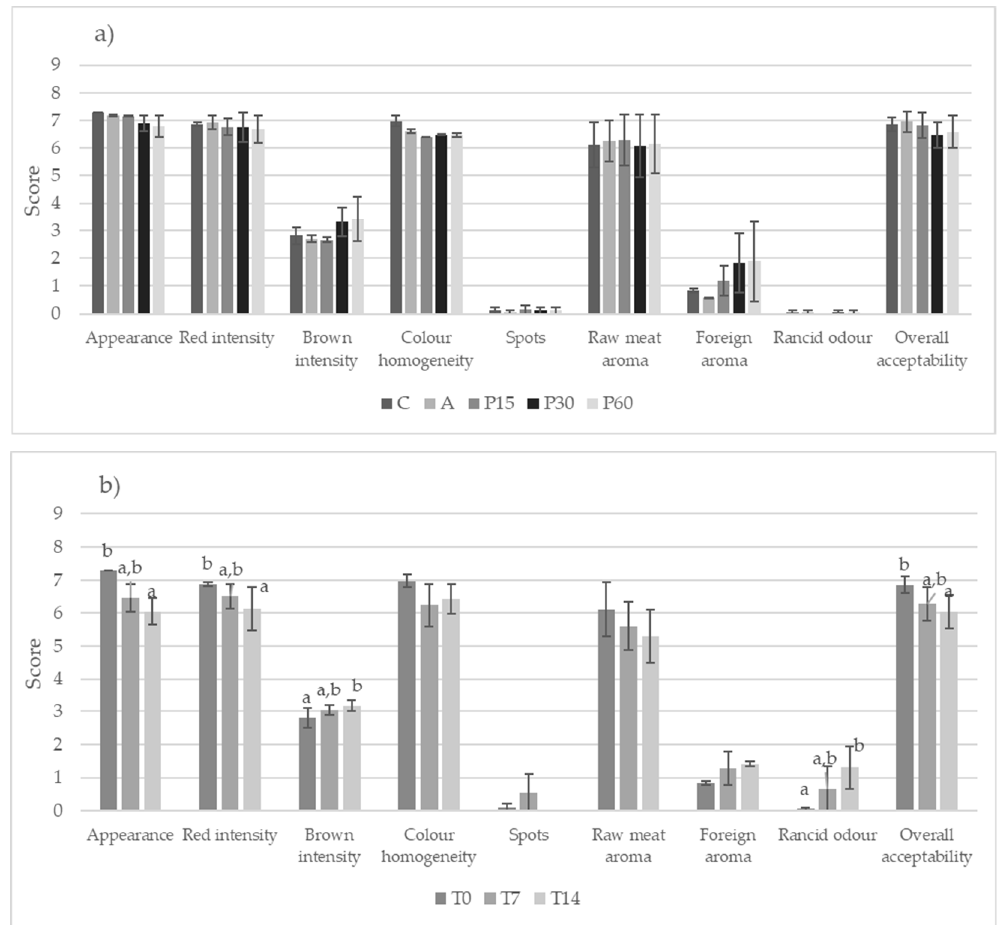
Figure 1. Sensory properties (appearance, red color intensity, brown color intensity, color homoge- neity, presence of spots, intensity of raw meat aroma, presence of foreign aroma, intensity of rancid odor, and overall acceptability) of the raw burgers related to the formulation ( a ) and storage time ( b ). The results are expressed as estimated marginal means and standard error of the mean of each a tt ribute, scored on a non-structured 0–9 intensity scale. Di ff erent le tt ers associated with each sen- sory property indicate signi fi cant di ff erences (Tukey’s test, p < 0.05). C = negative control, no anti- oxidant; A = positive control, +0.05% ascorbic acid; P15 = +0.15% dGCB extract; P30 = +0.30% dGCB extract; P60 = +0.60% dGCB extract. T0 = 0 days of refrigerated storage at 4 ± 1 °C; T7 = 7 days of refrigerated storage at 4 ± 1 °C; T14 = 14 days of refrigerated storage at 4 ± 1 °C.